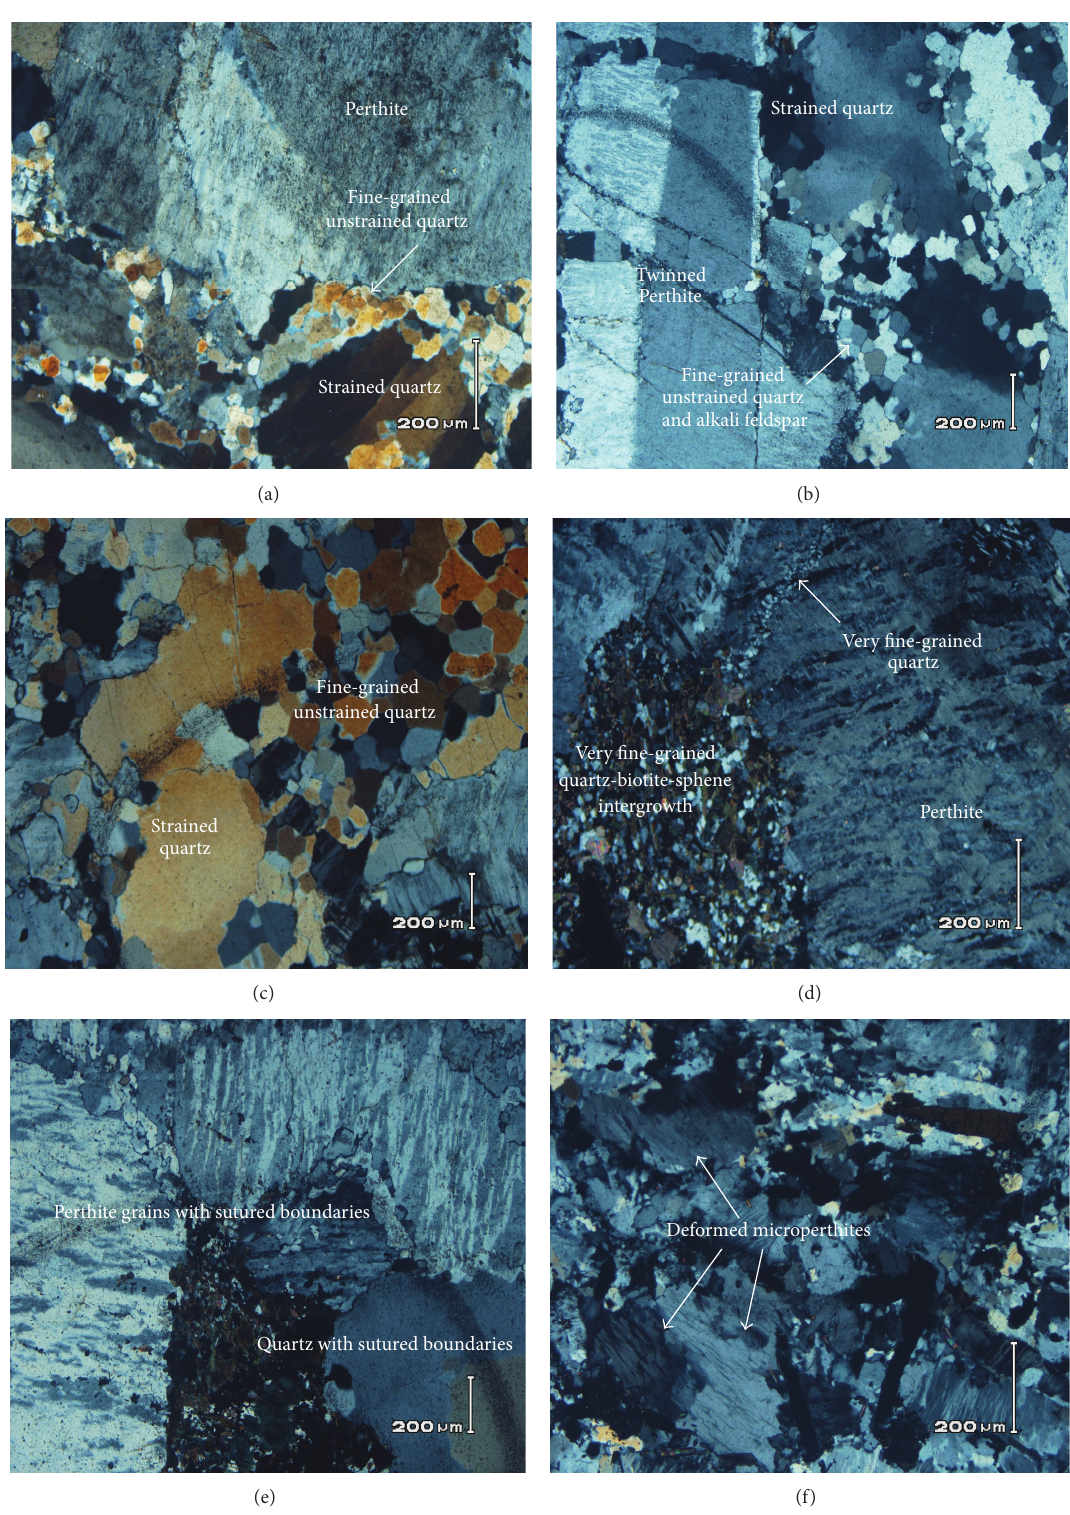
Figure 3: Photomicrographs showing important petrographic features in the investigated samples of megaporphyritic alkali granite (a and b), microporphyritic alkali granite (c), megaporphyritic alkali quartz syenite (d and e) and nepheline syenite (f). See text and Table 3 for